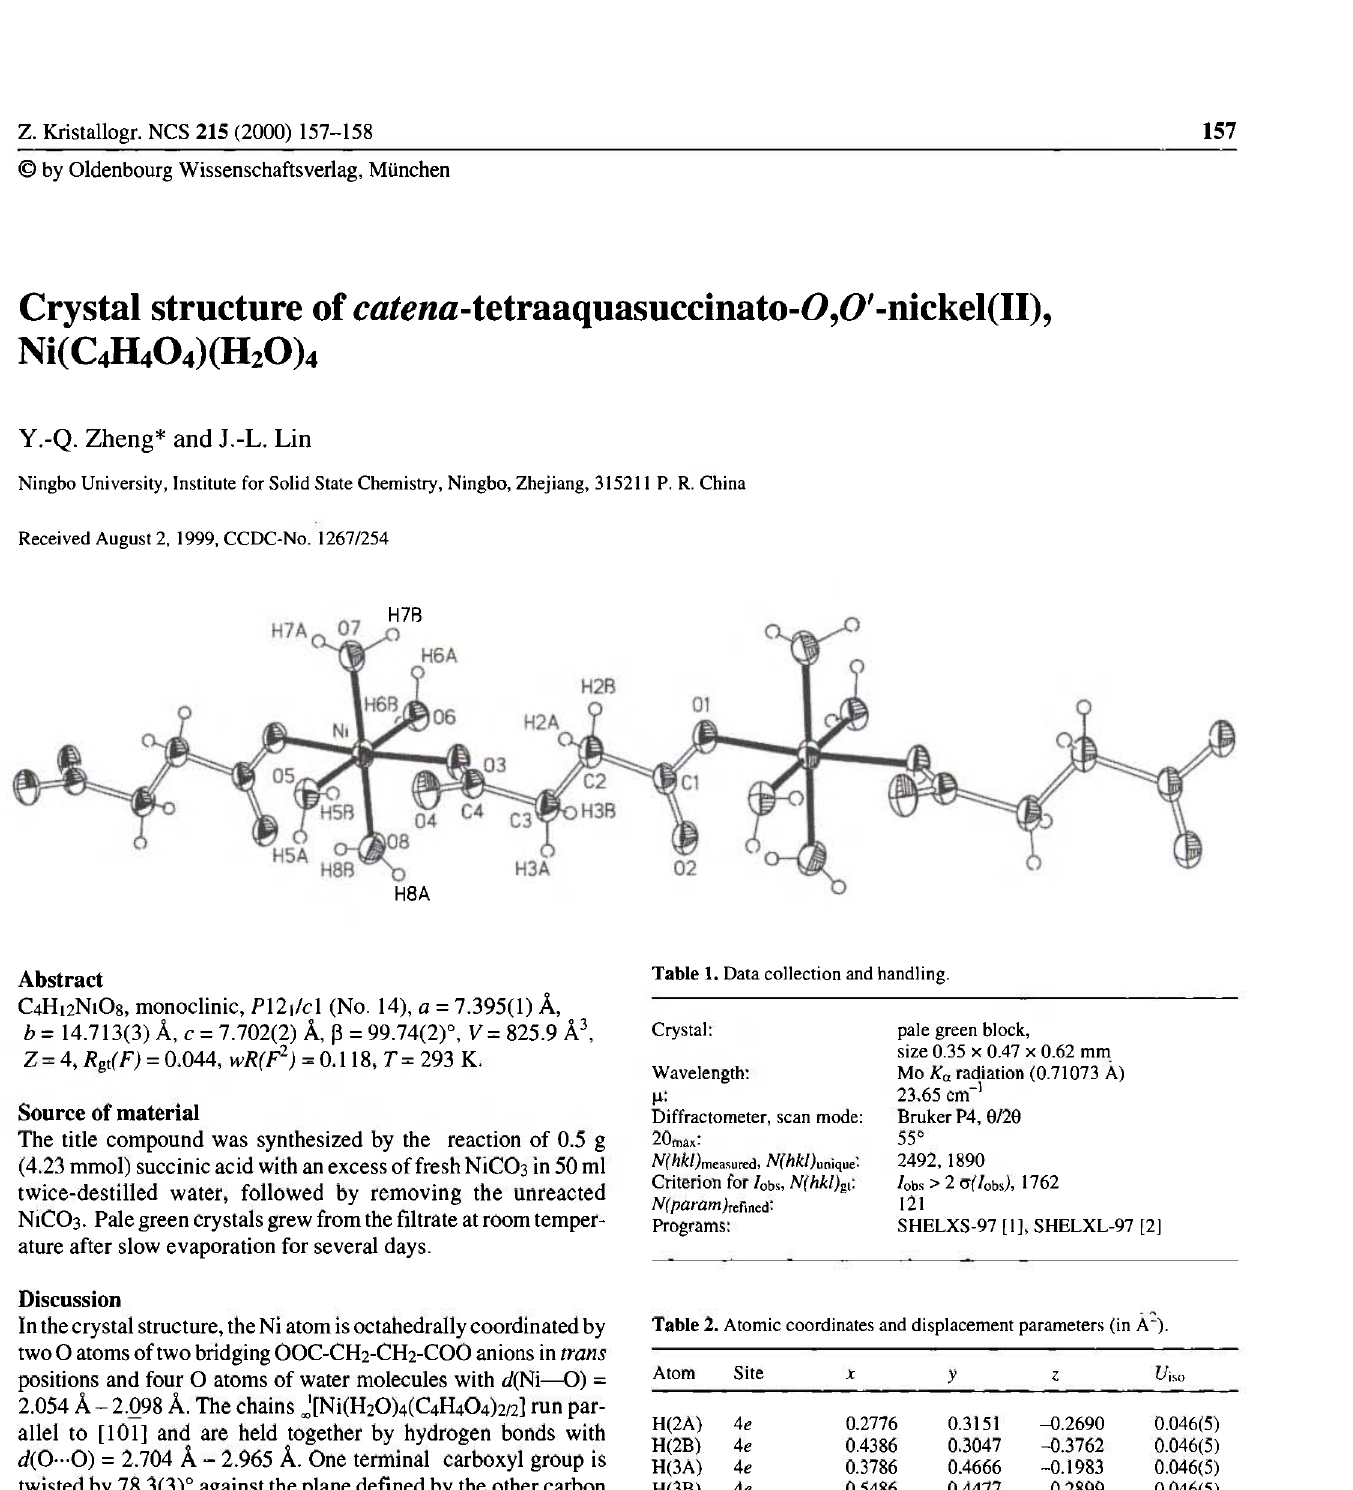
Table 2. Atomic coordinates and displacement parameters (in